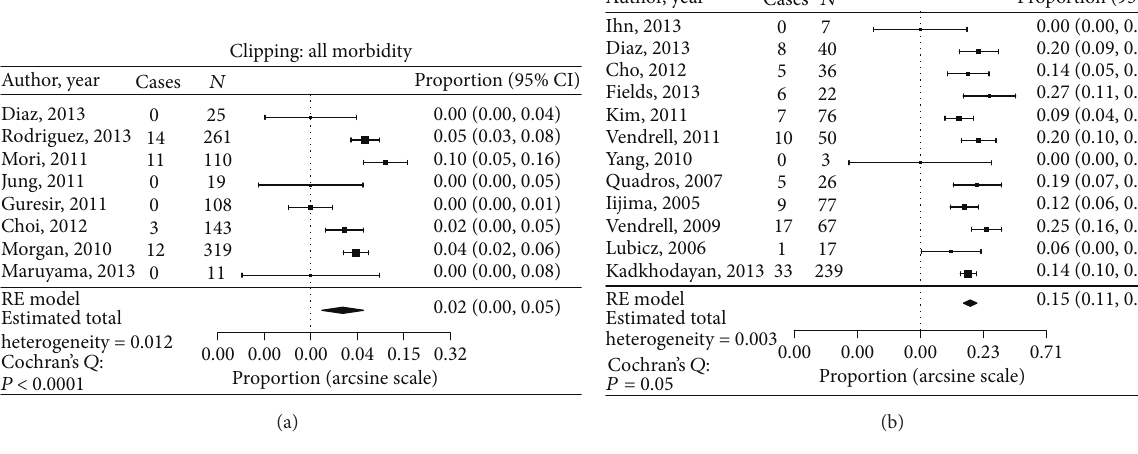
Figure 3: Data analysis of all morbidity cases in both clipped and coiled